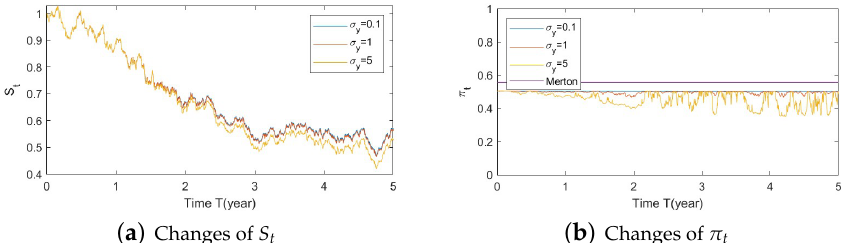
Figure A24. Illustrate the impact on ( a ) stock prices and ( b ) optimal stock allocations when varying σ y ( e . g ., σ y = 0.1,1,5 ) .